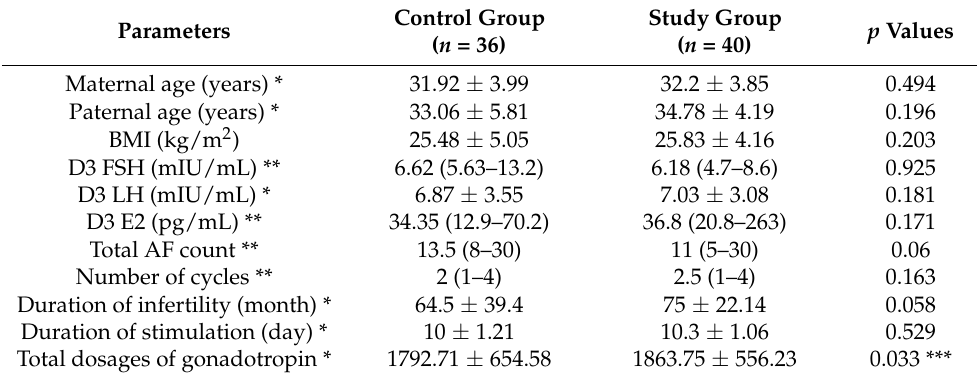
Table 1. Baseline features of participants.